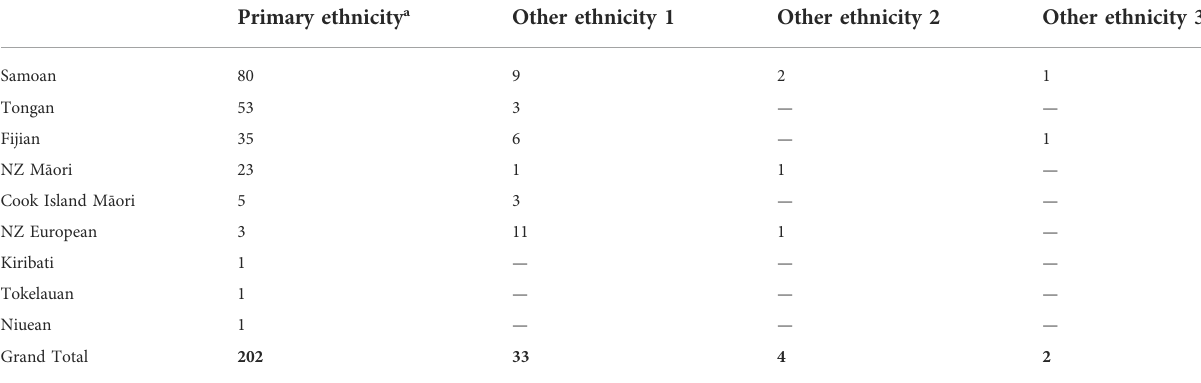
TABLE 1 Ethnicity details of